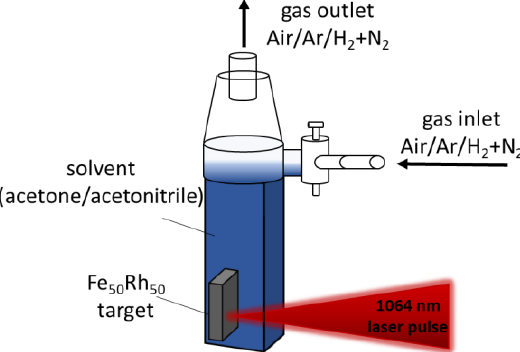
Figure 1. Schematic illustration of the “Schlenk” ablation chamber. The figure displays the laser setup and the different configurations with respect to solvents (acetone or acetonitrile) and gas flow. The gas inlet allows the manipulation of the atmosphere, with air, argon and a mixture of nitrogen and hydrogen. A laser with a pulse duration of 10 ps, repetition rate of 100 kHz and wavelength of 1064 nm was used.